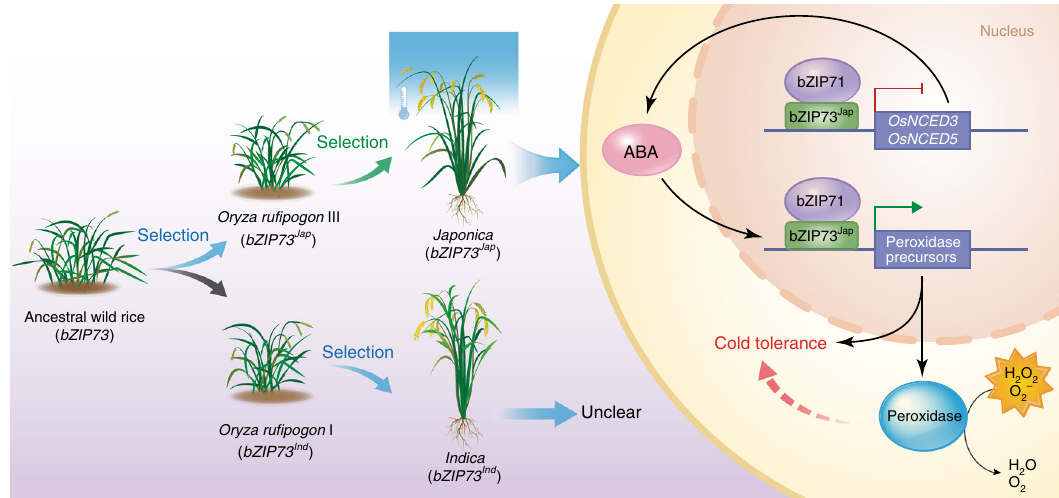
Fig. 7 Step-wise selection model of bZIP73 and the molecular mechanism of bZIP73 Jap -orchestrated cold tolerance in japonica